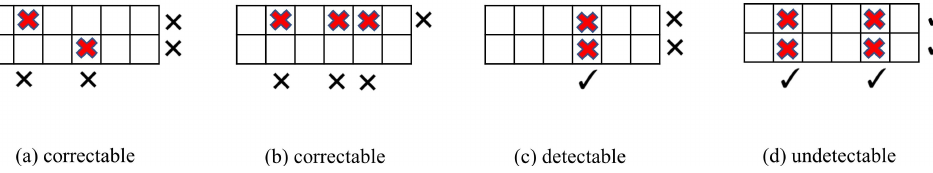
Figure 2. Four types of errors and the analysis of 2D Error Code Fault Detection and Correction Capability.